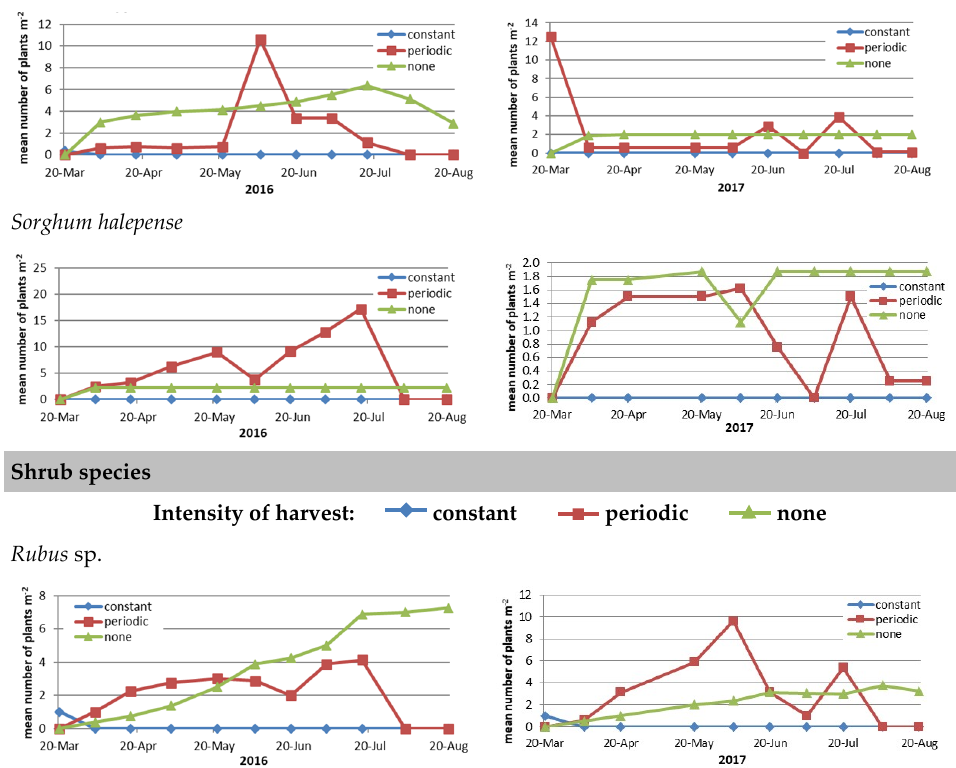
Figure 3. Plant species identified within the meadow naturally growing between the rows of the vineyard (expressed as mean number of plants per m 2 ) under different harvest treatments (constant, periodic, or none) during 20 March–20 August in 2016 and 2017.